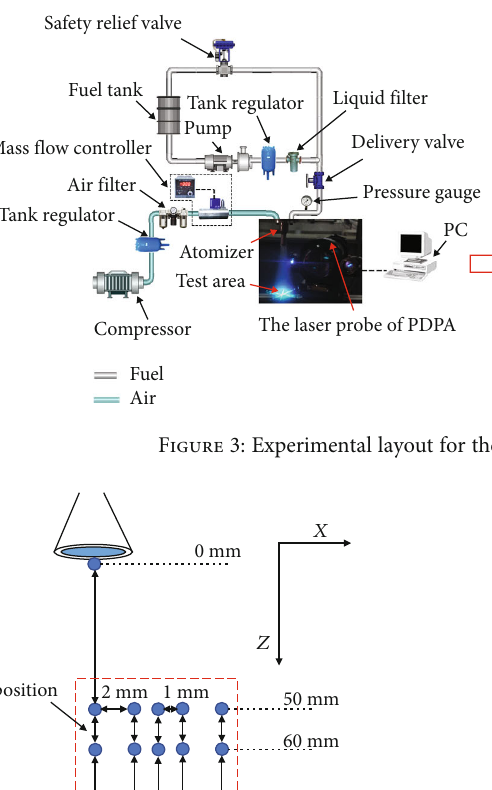
Figure 2: The diagram of the liquid breakup process at the internal atomizer.